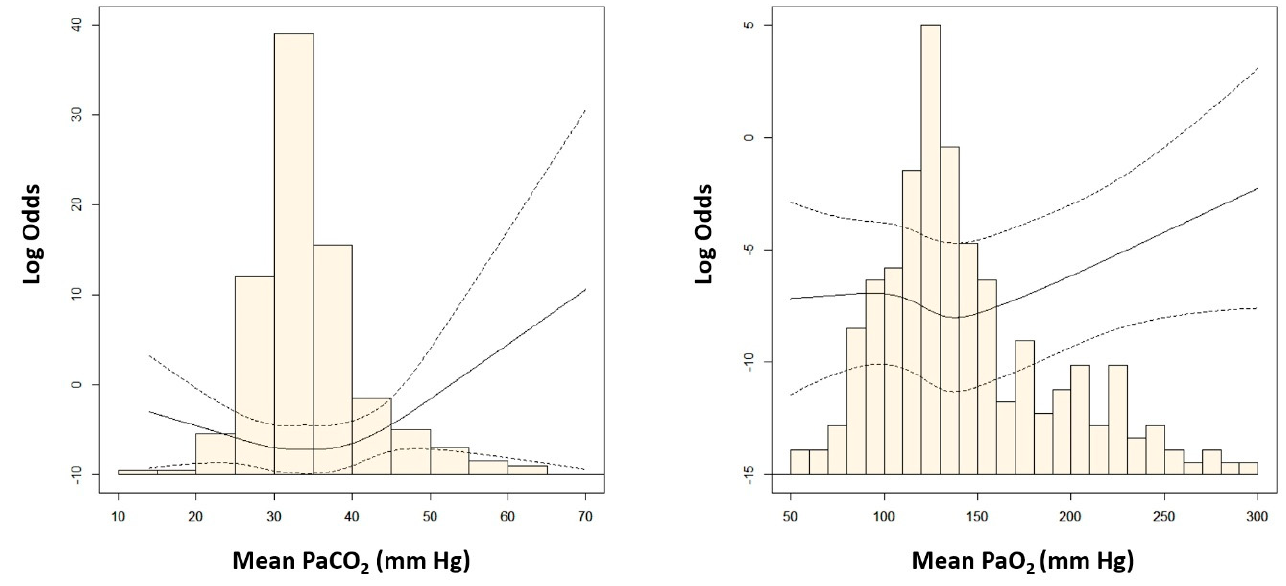
Figure 2. Adjusted odds ratio (OR) of poor neurologic outcomes according to the mean levels of arterial carbon dioxide (PaCO 2 ) and arterial oxygen (PaO 2 ). OR was log − transformed to reduce skewness.